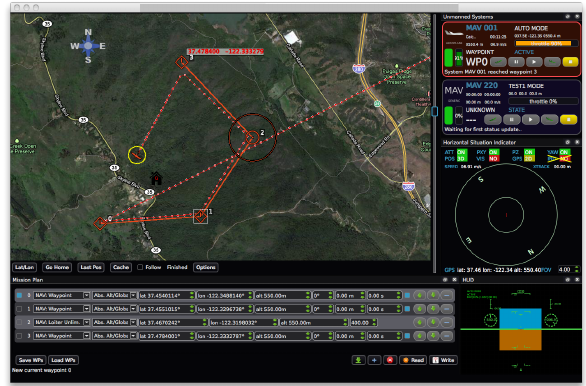
Figure 11: Operator perspective using the 2D moving map for mission planning and control.